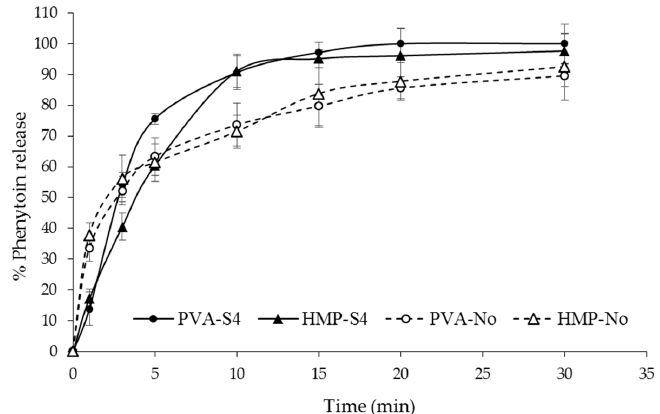
Figure 4. In vitro phenytoin release profile of PVA-S4, HMP-S4, PVA-No and HMP-No ODFs in Tris buffer pH 7.5 with 1% w / v sodium lauryl sulfate (SLS) at different time intervals from 0 to 30 min.